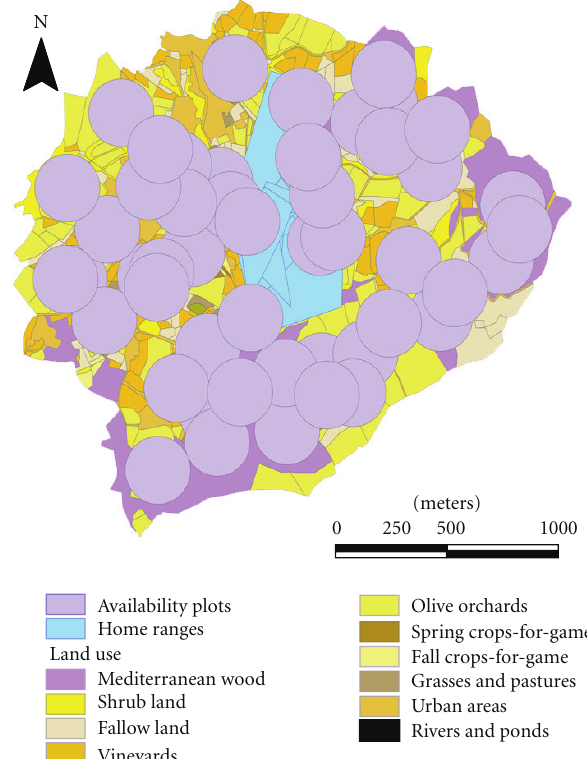
Figure 3: Land use polygon layer with the home range polygon shape of each individual animal and the land use circular plots generated with the Hawth tool (http://www.spatialecology.com/htools/), from the ArcGIS table of contents. Note: the land use layer, performed for clarity, is not required by the tool. With this set of data, 50 random circular plots of the average home range size of the birds in the case study (110m) were chosen across the study area.